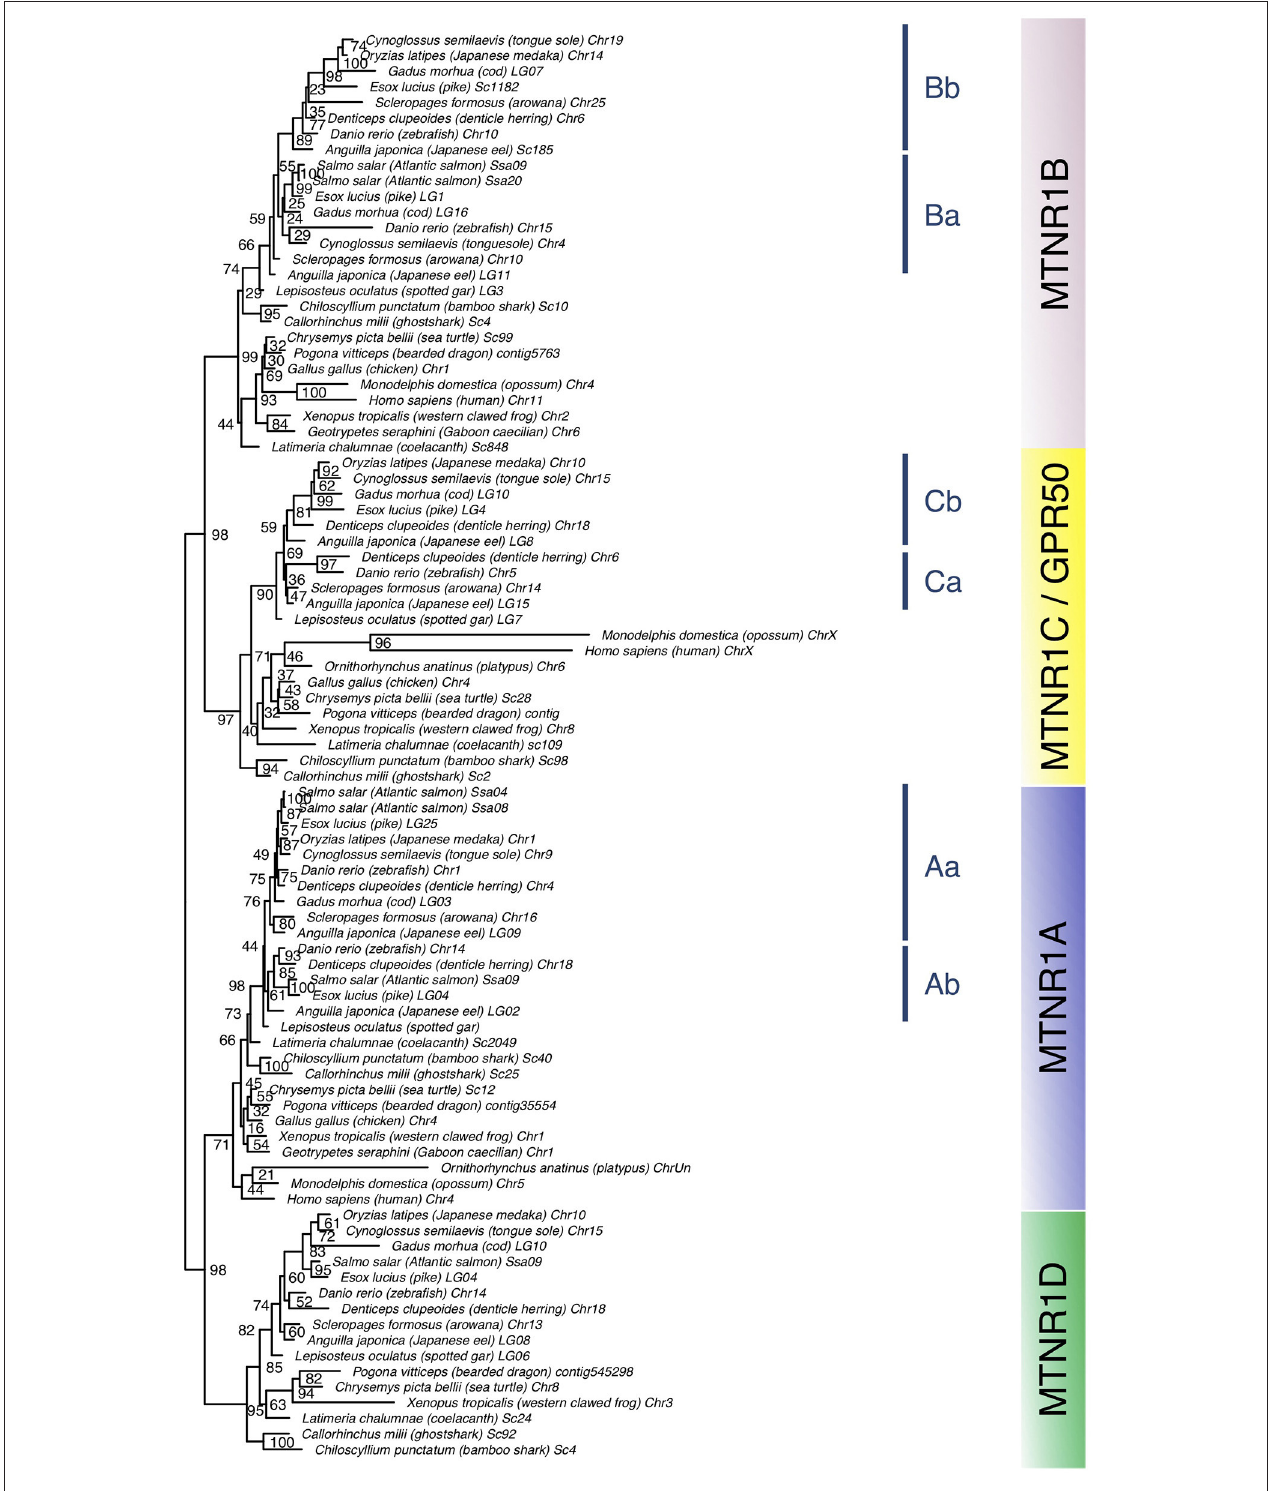
FIGURE 2 | Maximum-likelihood phylogeny tree of melatonin receptors of vertebrate representatives. Melatonin receptor phylogeny was inferred from alignment of the deduced amino-acid sequences of melatonin receptor using the PhyML algorithm with the AIC selection criteria of the Smart Model Selection and the tree Subtree Pruning and Regrafting (SPR) improvement algorithm. The four gnathostome monophyletic clades are indicated with different background colors. The blue line